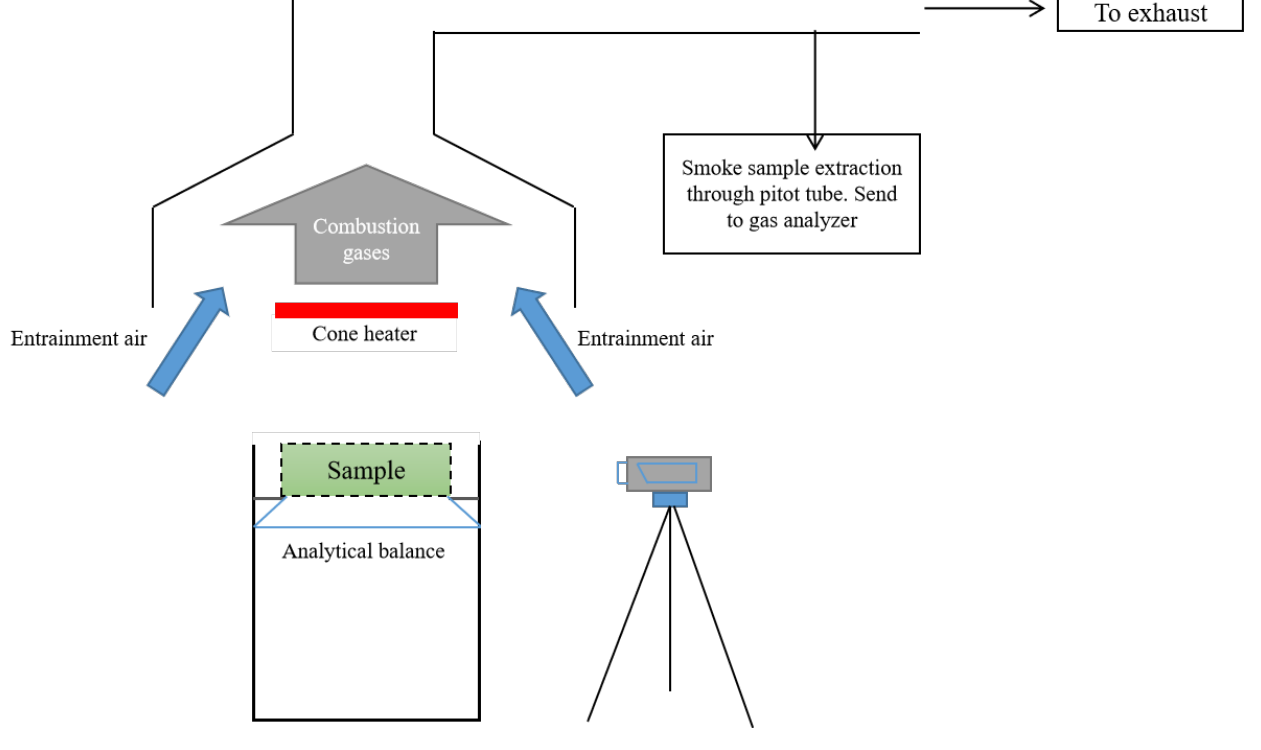
Figure 1. Schematic of experimental setup. Table 1. Experimental conditions.